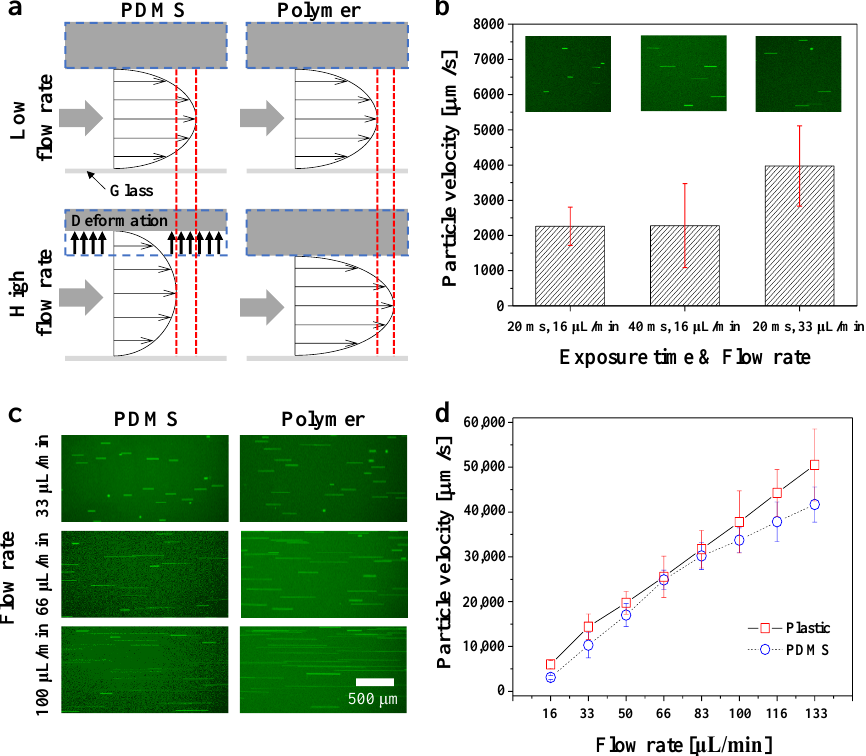
Figure 3. Channel deformation due to pressure-driven flow. ( a ) Schematic illustration of deformation of PDMS channel due to pressure-driven flow. Dashed blue and red lines represent channel deformation with pressure and decrease in velocity profile with deformation, respectively. ( b ) Particle velocity measurement in PDMS channels at different exposure times and flow rates. Inset images show displacement of particles at each condition. ( c ) Fluorescence images showing displacement of particles in each channel at flow rates of 33, 66, and 100 μ L/min. Scale bar represents 500 μ m. ( d ) Particle velocity measured based on flow rate in each channel. At low flow rates, the particle velocity in the PDMS channels was smaller than that in the polymer channels.